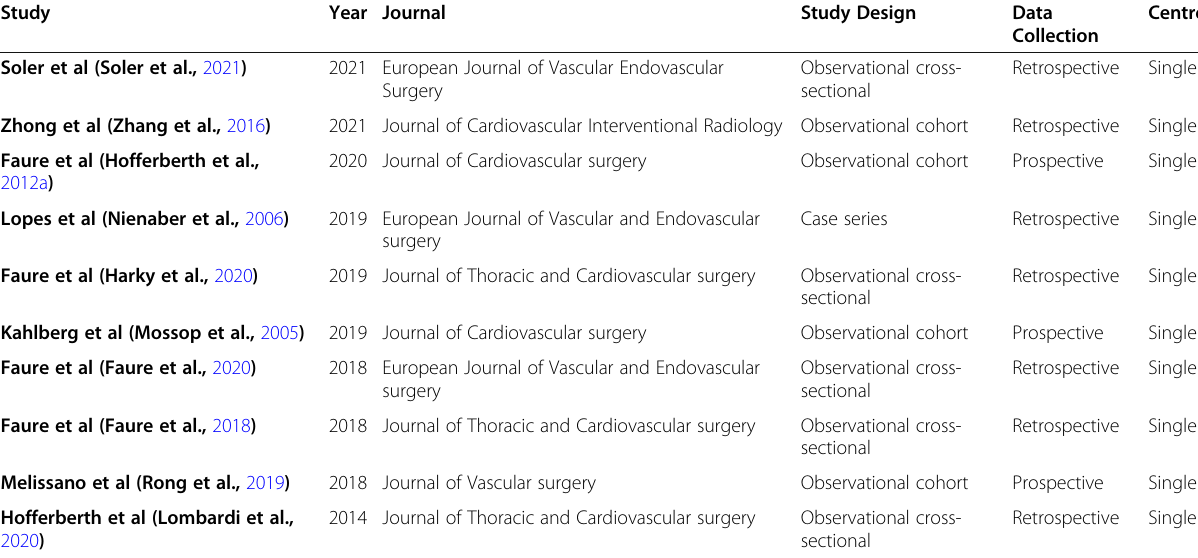
Table 3 Updated studies assessing the STABILISE technique